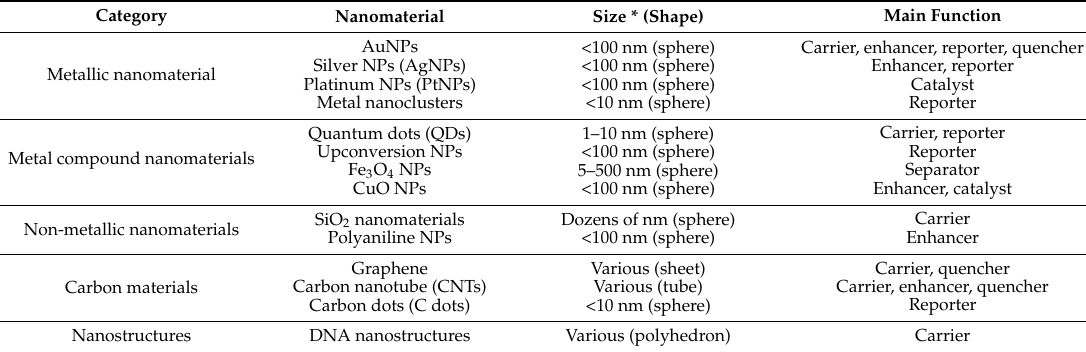
Table 1. Summary of types and functions of commonly used